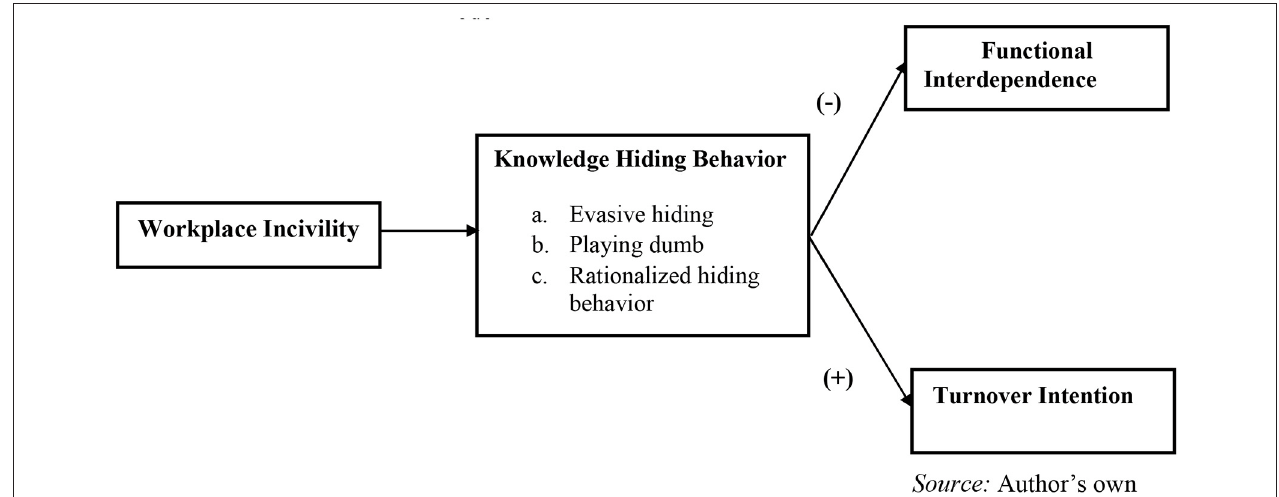
FIGURE 1 | Hypothesized